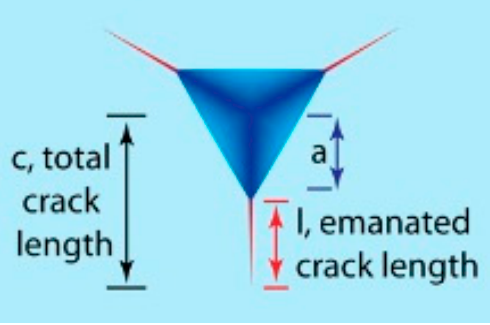
Figure 21. Schematic diagram of a cube-corner indenter and the residual indent with surface cracks emanating from the indent corners. (Reproduced with permission from Elsevier, Reference 42).